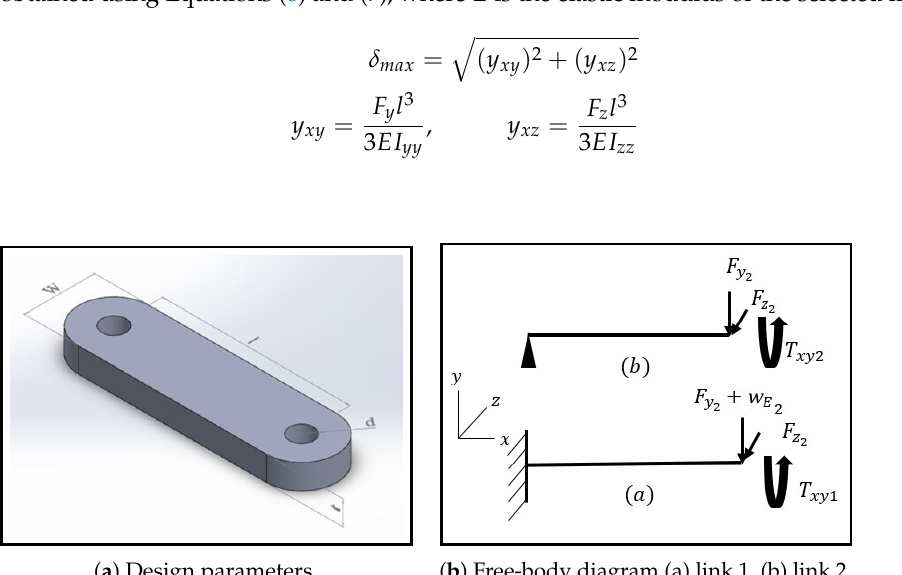
Figure 2. Specification of